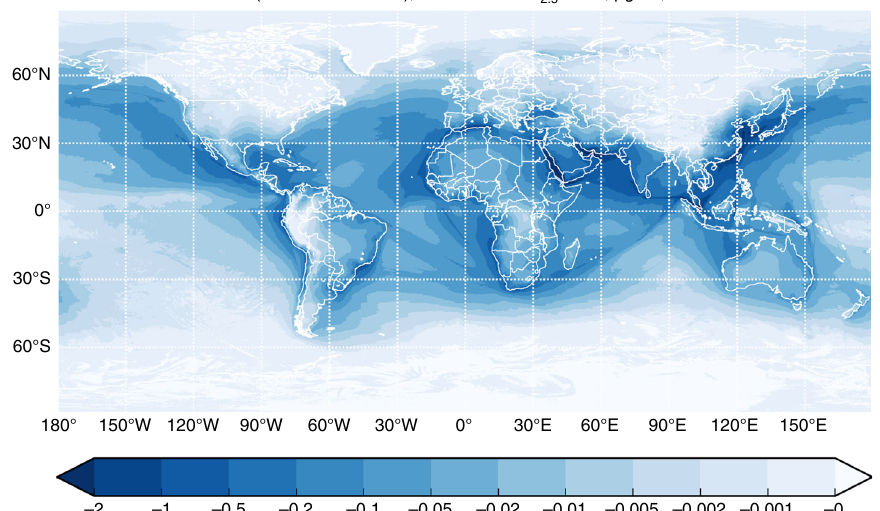
Fig. 2 Reduction in annual PM 2.5 concentrations due to low-sulphur fuel standards. Model results showing the reduction in annual PM 2.5 concentrations in micrograms per cubic meter due to the implementation of the International Maritime Organization ’ s global fuel sulphur standard in